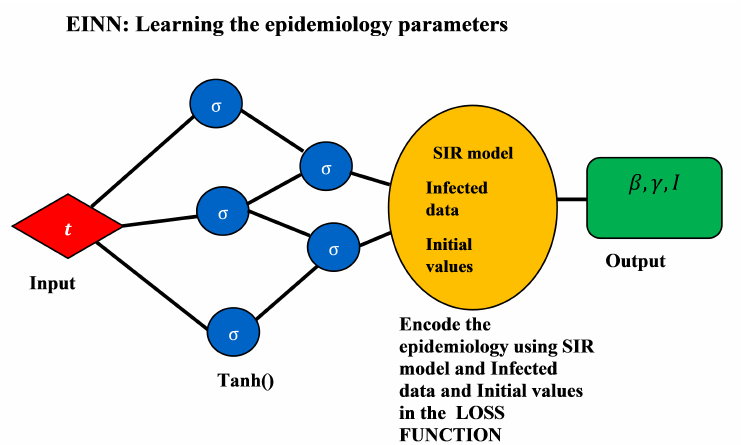
Figure 1. Schematic diagram of Epidemiology Informed Neural Network (EINN). The processed daily infected data at time t is passed into the network as seen in red diamond input layer. A hyperbolic tangent activation function is applied to the processed data in the hidden layer. The loss function is defined to incorporate the initial values, data and the residual from the systems of differential equations in (1) in yellow circle. The output layer produces the learned β , γ and the infected group.